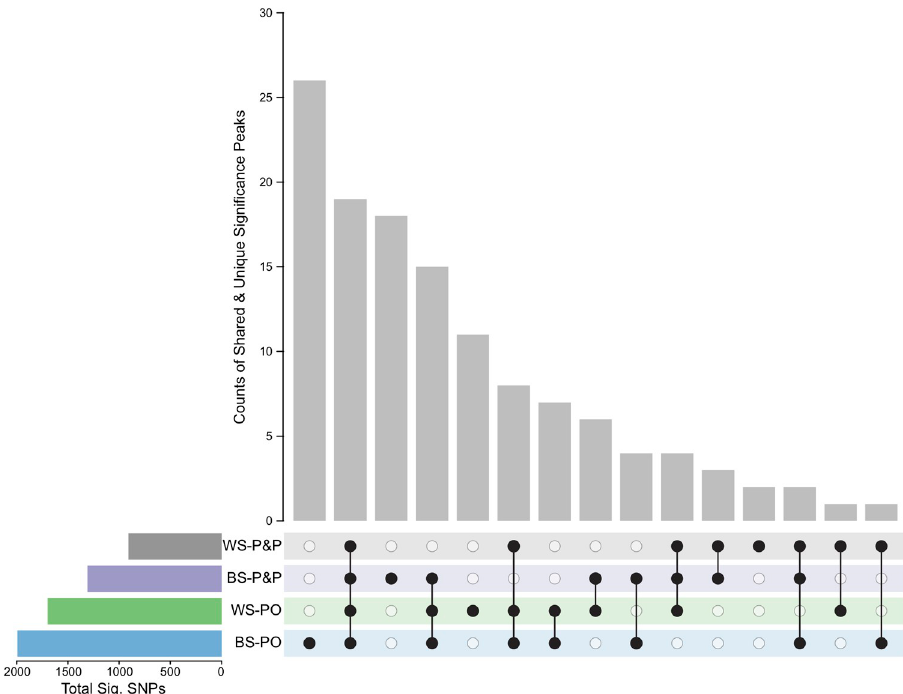
Fig 4. Breakdown of significance peaks from Model 2. The counts of significance peaks are shown along with the combination of regimes contributing to that count. Unique peaks are represented by a single black dot for the given regime. Shared peaks have multiple connected black dots. The total number of significant SNPs within each regime is given.